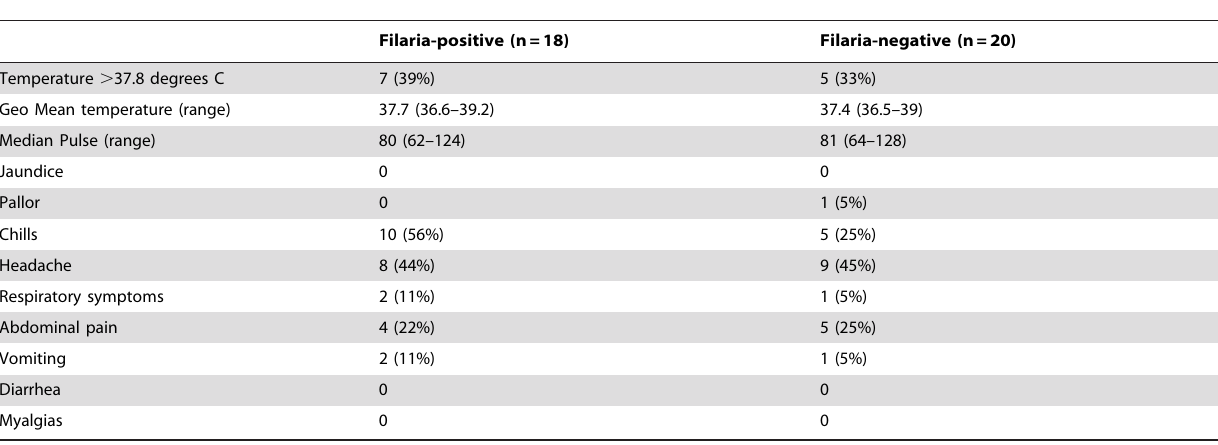
Table 3. Clinical signs and symptoms during first episode of clinical malaria.